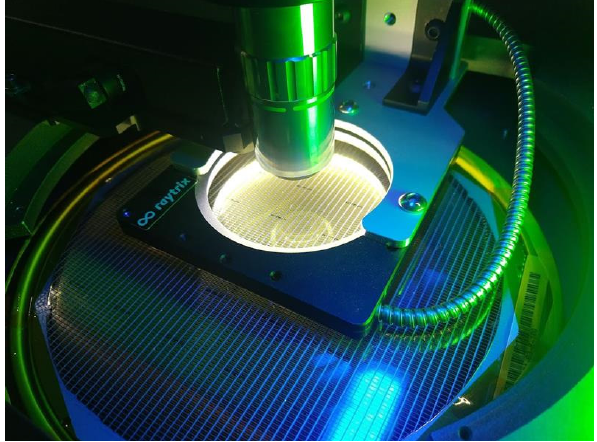
Figure 1. A close-up view of the developed plenoptic camera.